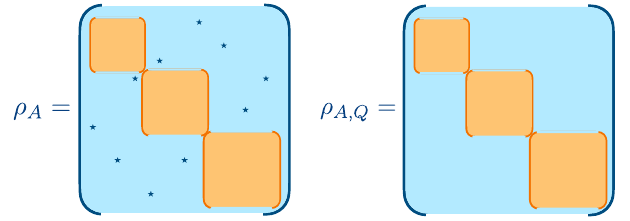
Fig.1|Thedensitymatrices ρ A and ρ A , Q enteringinthede fi nitions(1)and(2)of theentanglementasymmetries. Inthe eigenbasisofthe subsystemcharge Q A , ρ A generically displays off-diagonalelements. Under a projective measurement of Q A , we get ρ A , Q , where the off-diagonal blocks are annihilated. The difference Δ S ð n Þ A between the entanglement entropies of these matrices is our probe of symmetry breaking.